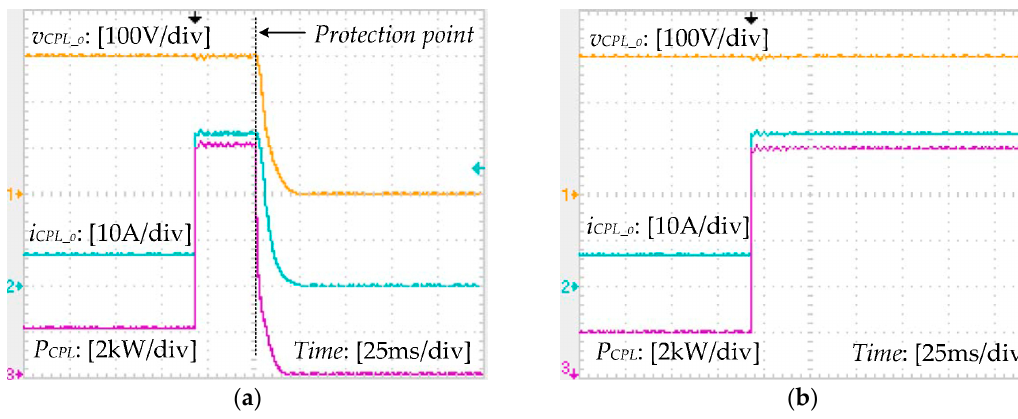
Figure 10. Main operating waveforms of the CPL when load power is changed from 2 kW to 10 kW. ( a ) with conventional PI control; ( b ) with the proposed ADRC.